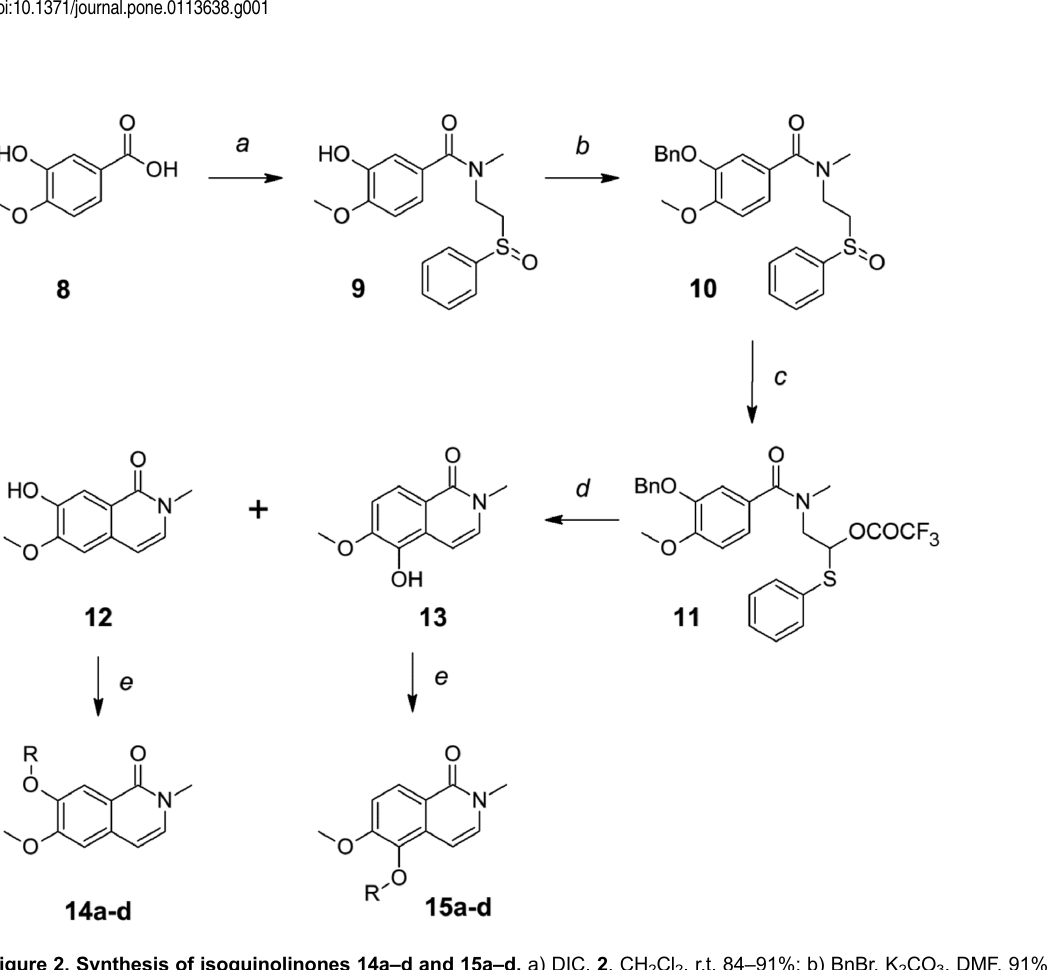
PLOS ONE | DOI:10.1371/journal.pone.0113638 December 5,